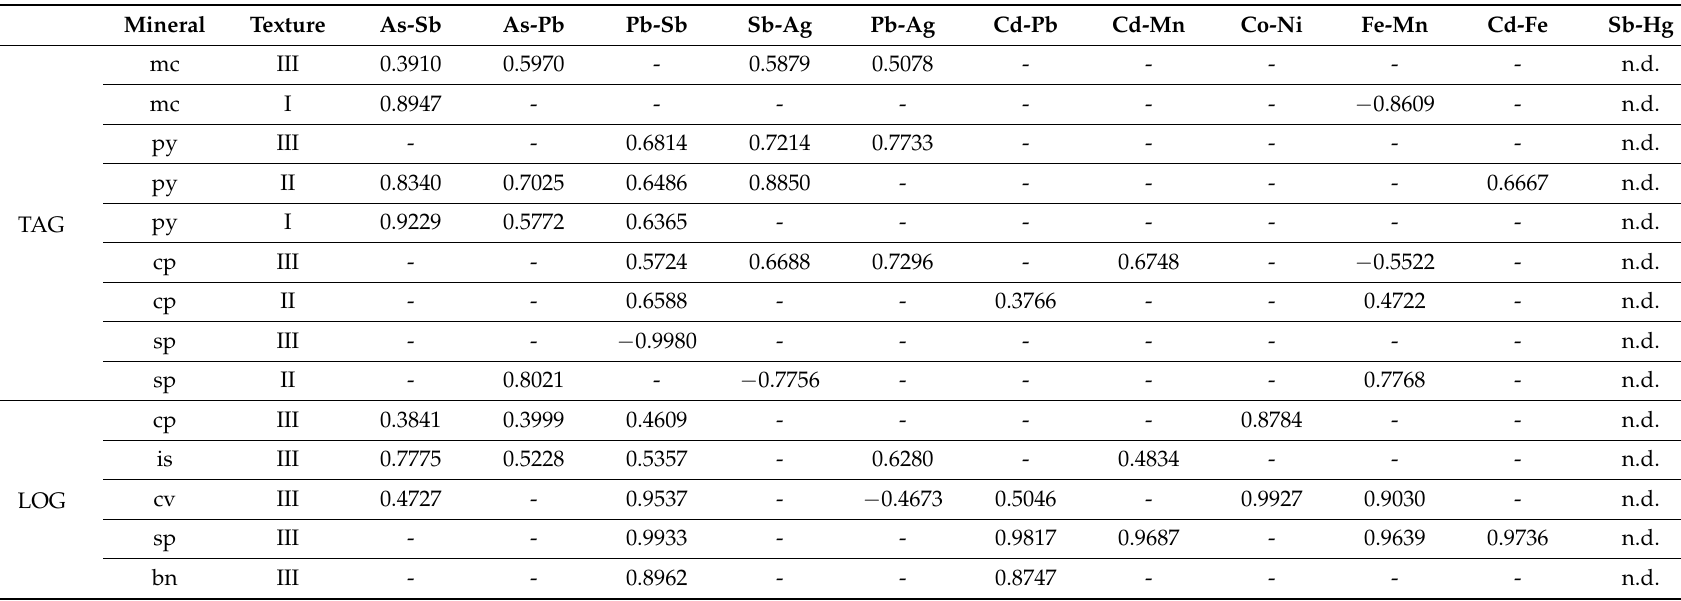
Table 5. Correlation coefficients (R 2 ) for element pairs categorised by hydrothermal fields, minerals and texture. (-) Hyphens represent correlation coefficients that were calculated but are statistically insignificant: if the p-value is >0.05, see text for discussion. n.d. indicate where correlation coefficients could not be calculated as the element(s) were not analysed, e.g., Hg. Abbreviations used in this table include py (pyrite), mc (marcasite), pyr (pyrrhotite), cp (chalcopyrite), is (isocubanite),